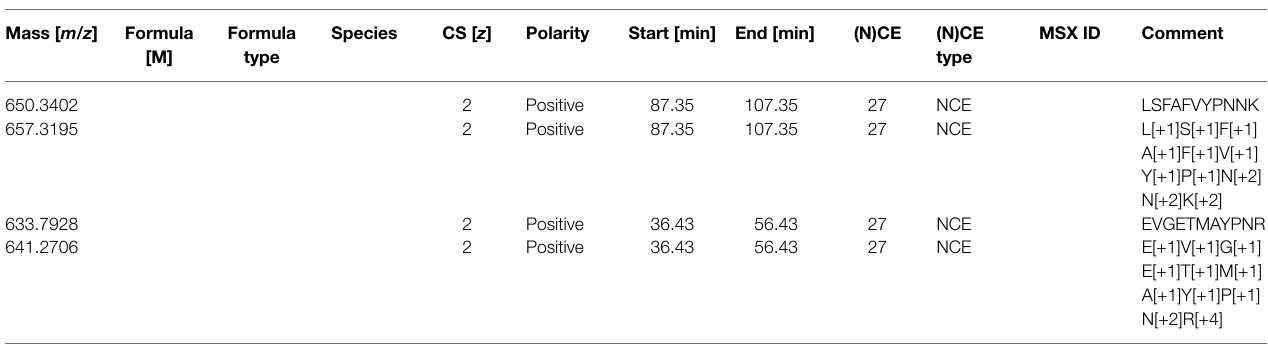
TABLE 4 | PRM template as an inclusion